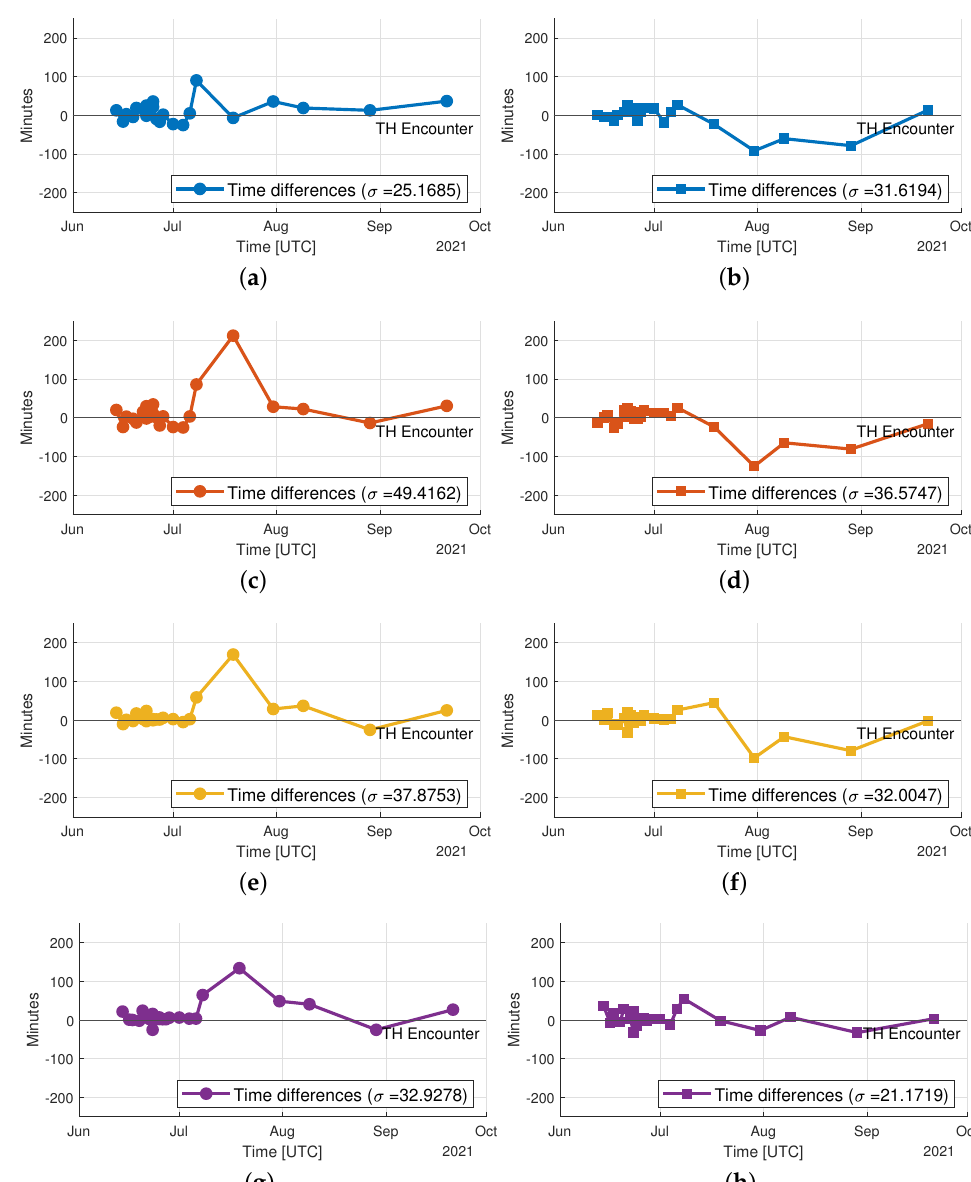
Figure 5. Time differences between the time at which the reference values were first encountered ( TH Encounter ) and maintained for at least five minutes, and the estimated starting times for the Strombolian activity (circles) and lava fountains (squares) for each episode (reported in Table 3). ( a , b ) refer to RB1, ( c , d ) to RB2, ( e , f ) to RB3, ( g , h ) to